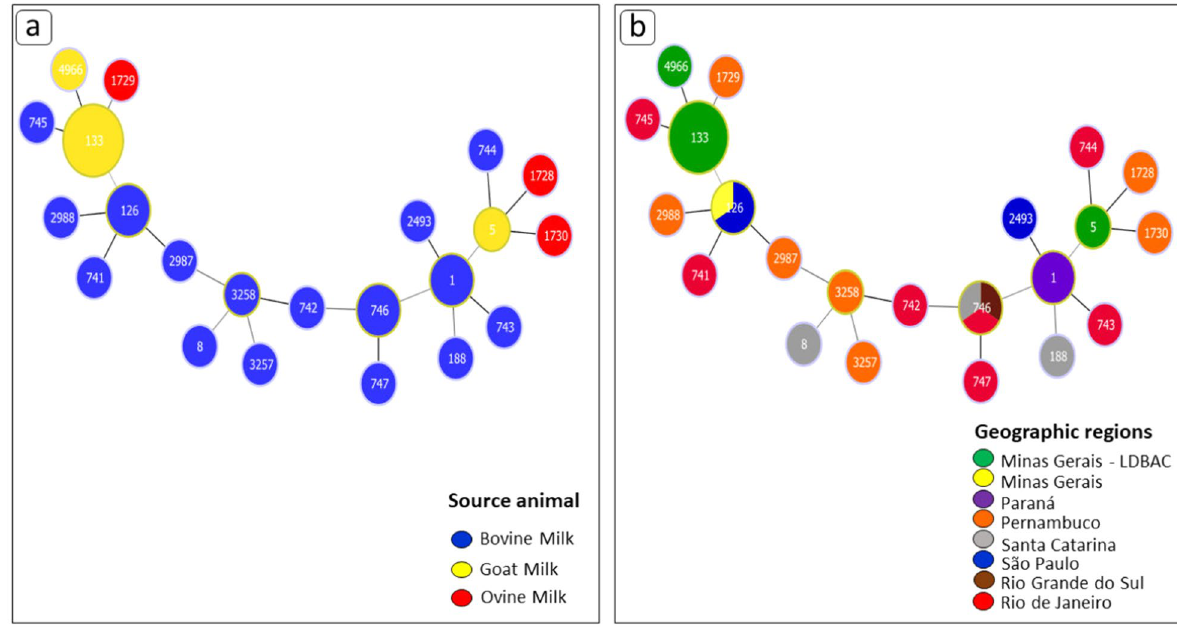
Figure 3. The MS tree of the 22 STs was inferred by Phyloviz based on allelic profiles. Each circle indicated a ST (node) or complex clonal (CC), and a larger size of the circle corresponded to a larger number of strains included, in other words, size of the circle is logarithmically proportional to the number of strains represented by the ST. The background colors indicated different CCs. ( a ) Each color represents a different host for Staphylococcus aureus (bovine, caprine and ovine) obtained from milk of animals with mastitis. The circles with blue colors denote the source of the sample from bovine, yellow from goat and red from ovine. Created with PHYLOViZ software. ( b ) The isolates are colored according to isolated areas, distinguishing between samples from 7 Brazilian states. The CC referenced in green are from milk of goats with persistent goat mastitis (GPM). Created with PHYLOViZ software.